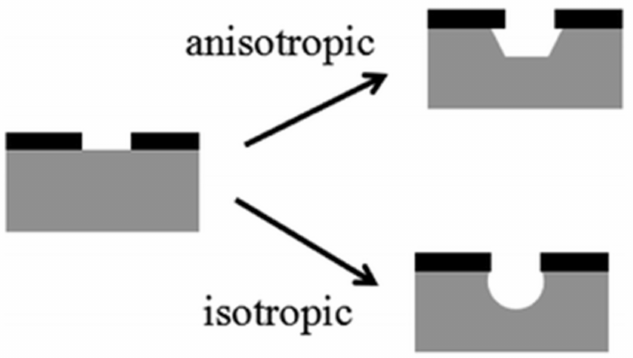
Figure 7. Etching profiles generated with [146] isotropic and anisotropic etching. (Adapted from Ref. [146]).